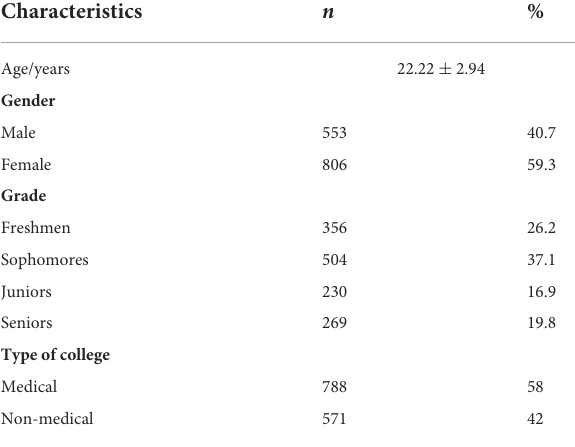
TABLE 1 Demographic characteristics of college students ( N =